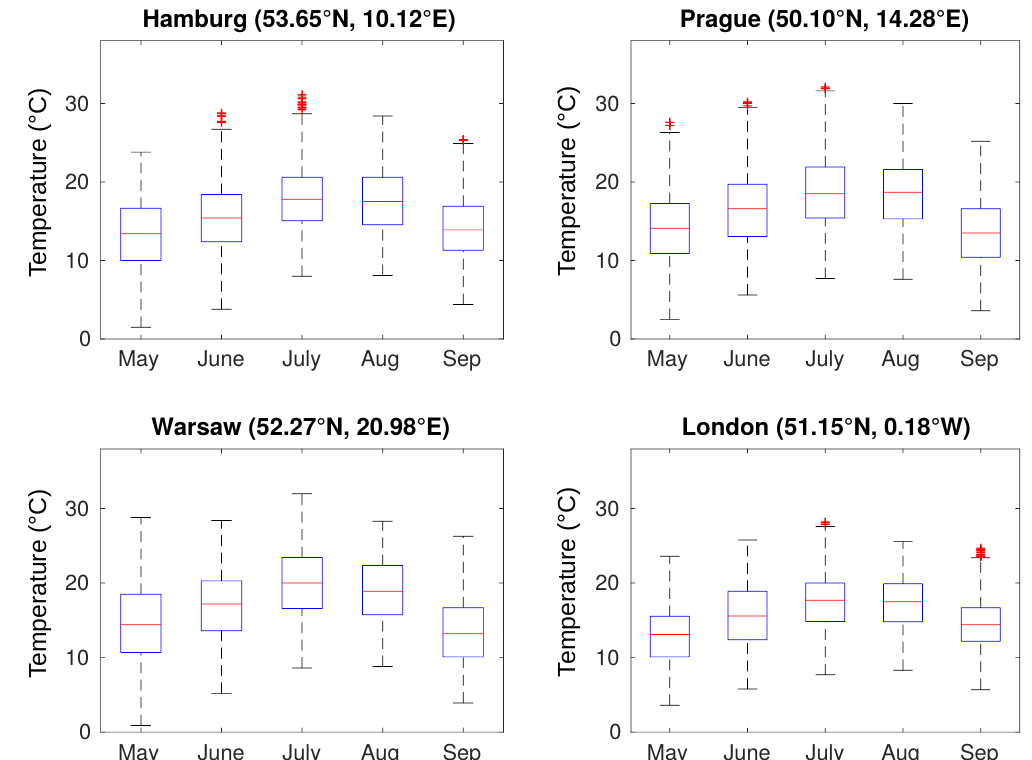
Figure 5. Outdoor air temperatures in the cities located between the 50th and 55th parallels.